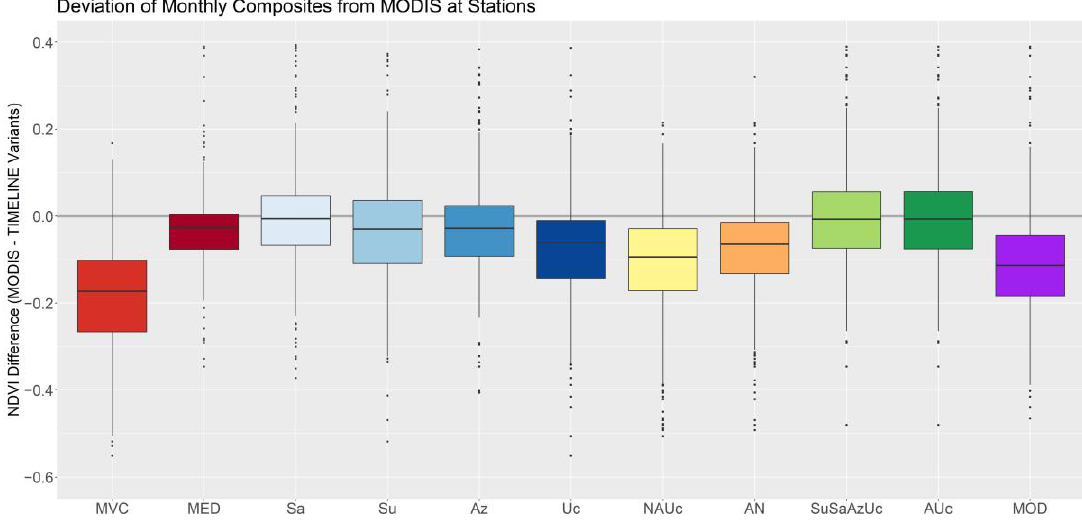
Figure 9. Deviations of monthly composites from MODIS values at 37